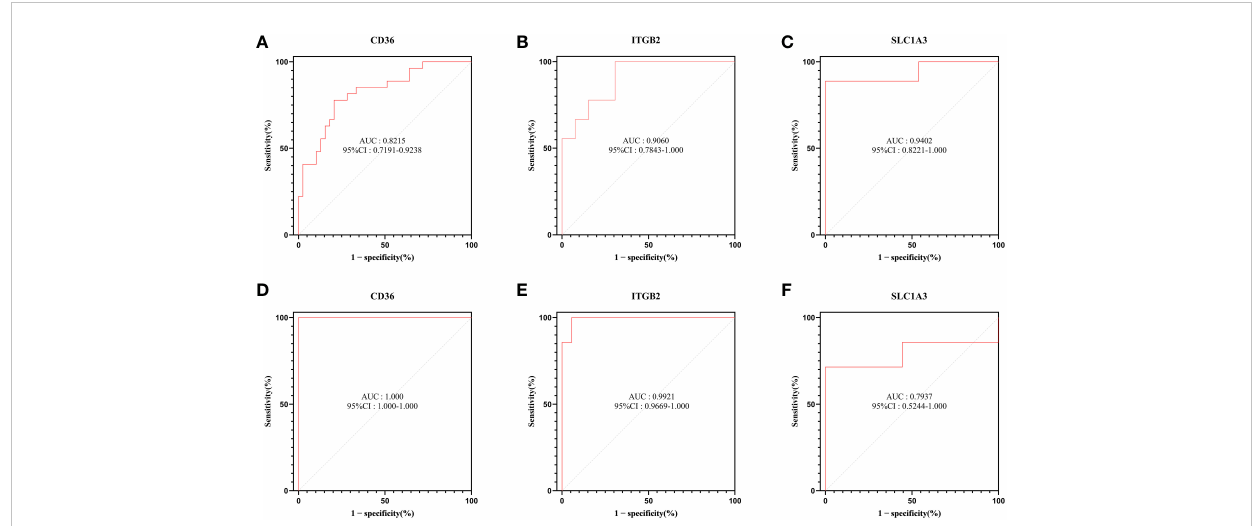
FIGURE 8 ROC curve analysis. (A – C) Hub genes in the GSE30528 dataset were analyzed using ROC curves. (D – F) Hub genes in the GSE104948 dataset were analyzed using ROC curves.